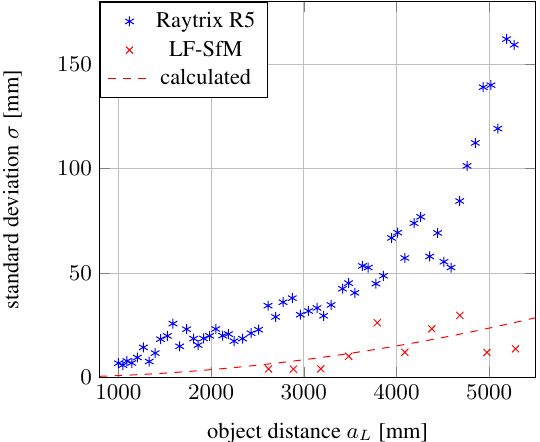
Figure 8. Standard deviation measured over object distance. Blue asterisk: Standard deviation measured by a Raytrix R5 camera. Red cross: Calculated standard deviation of light-field based vi- sual odometry after a translation of 20 cm. Red dashed line: Stan- dard deviation for a stereo camera pair with baseline distance of 20 cm, intrinsic parameters similar to the Raytrix camera, at a disparity standard deviation of 0 . 3